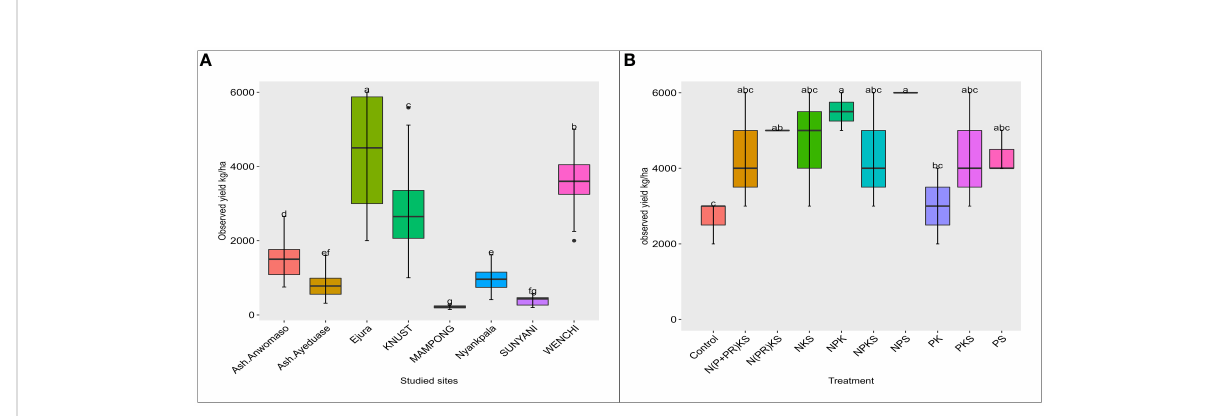
FIGURE 4 (A) Observed yield among study sites; (B) observed yield at Ejura by treatment. The small letters are the signi fi cance of the statistical differences of the treatments. The only meaning is to show which treatment are signi fi cantly different and the ones that are not signi fi cantly different. The letters were automatically generated by the statistical test.